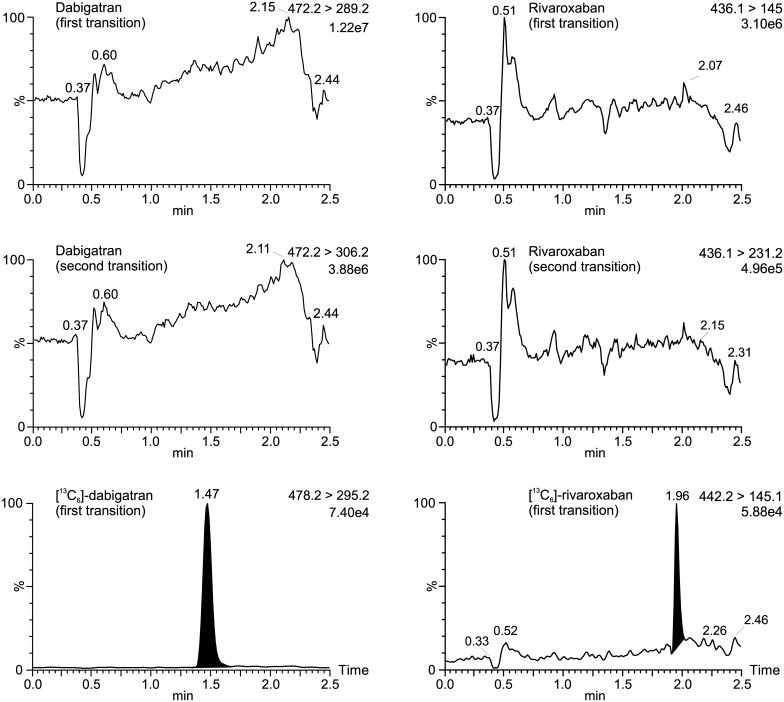
Ion suppression profiles of DOACs.Ion suppression profile for dabigatran is depicted on the left and for rivaroxaban is depicted on the right, respectively, performed with a post-column flow injection of 0.1 mg/L drug into the UPLC elute of drug-free samples. In addition, the mass transition of the corresponding internal standard is shown. Data were normalized to largest peak in the plots. An estimated peak height is shown in the plots below the transition remark.